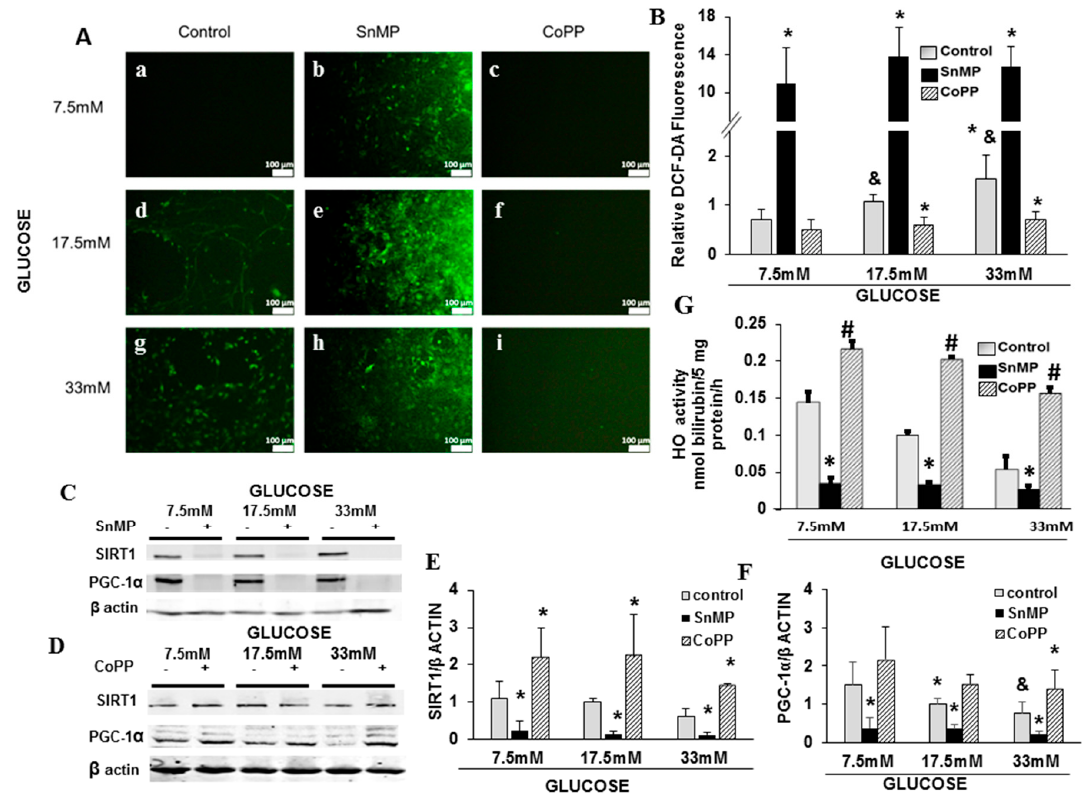
Figure 3. HO ‐ 1 is required for the expression of SIRT1 and PGC ‐ 1 α . Neonatal rat cardiomyocytes were exposed to 7.5 mM, 17.5 mM, and 33 mM of glucose and treated with SnMP or cobalt protoporphyrin (CoPP). Cells were stained with 2 ′ , 7 ′‐ dichlorofluorescin diacetate (DCF ‐ DA) ( A a–i), and fluorescence was measured using a fluorimeter ( B ). Representative western blots for SIRT1 and PGC ‐ 1 α for cells treated with SnMP ( C ) and CoPP ( D ), densitometry analysis for SIRT1 ( E ) and PGC ‐ 1 α ( F ). HO activity in the presence and absence of SnMP and CoPP ( G ). Results were normalized to the group exposed to 17.5 mM of glucose. * p < 0.05 vs. control, & p < 0.05 vs. 7.5 mM of control, # p < 0.05 vs. SnMP. n = 4 in each group. Values represent mean ± SD.